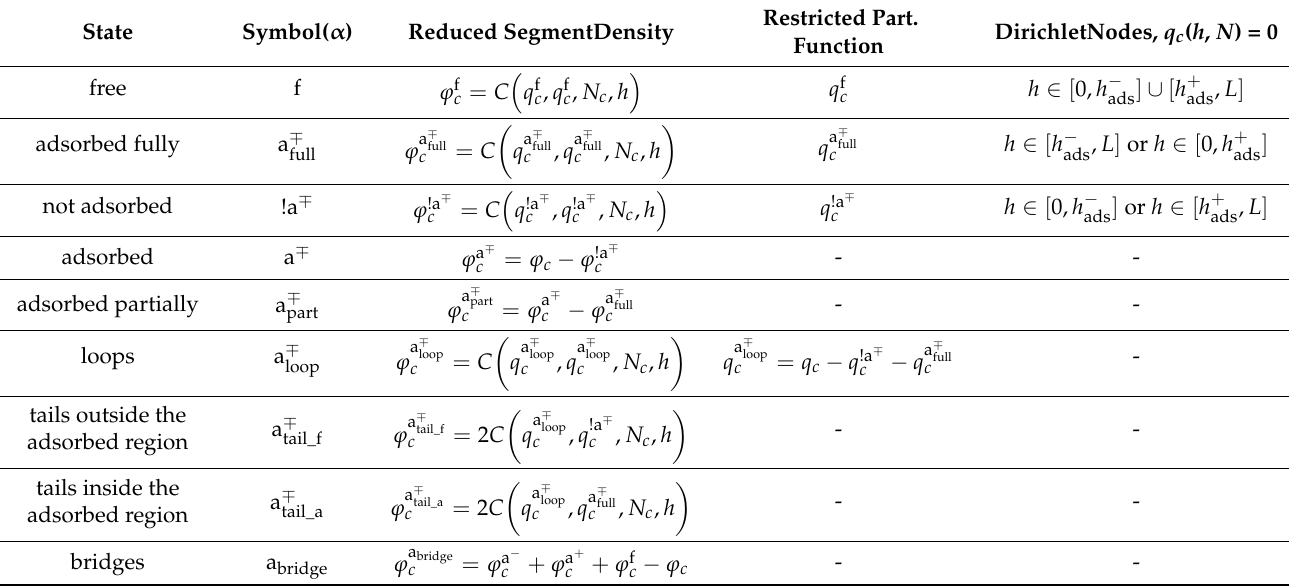
Table 1. Reduced densities, partition functions, and constraints for evaluating each state and